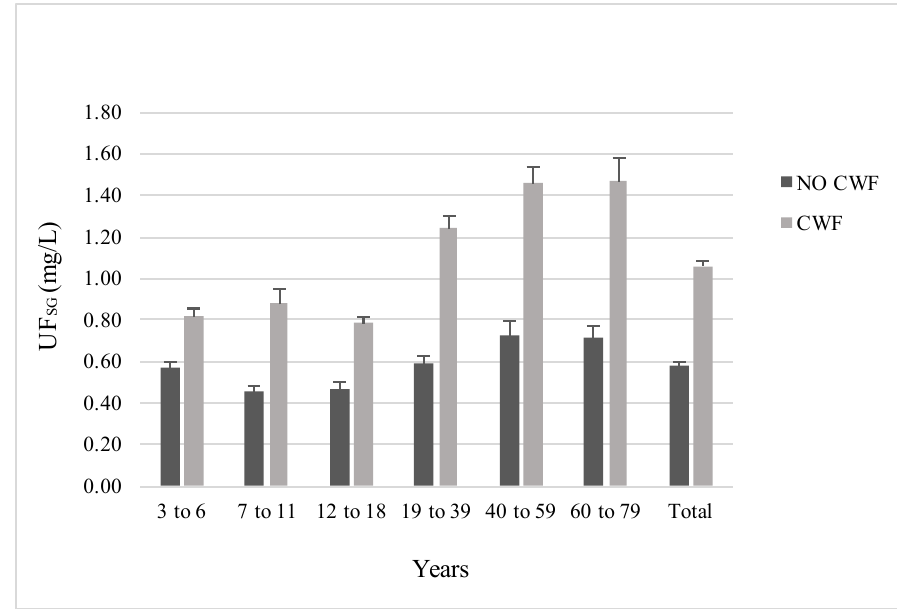
Figure 2. Mean levels of UF SG by age group and CWF status. Error bars represent the standard error of the mean.